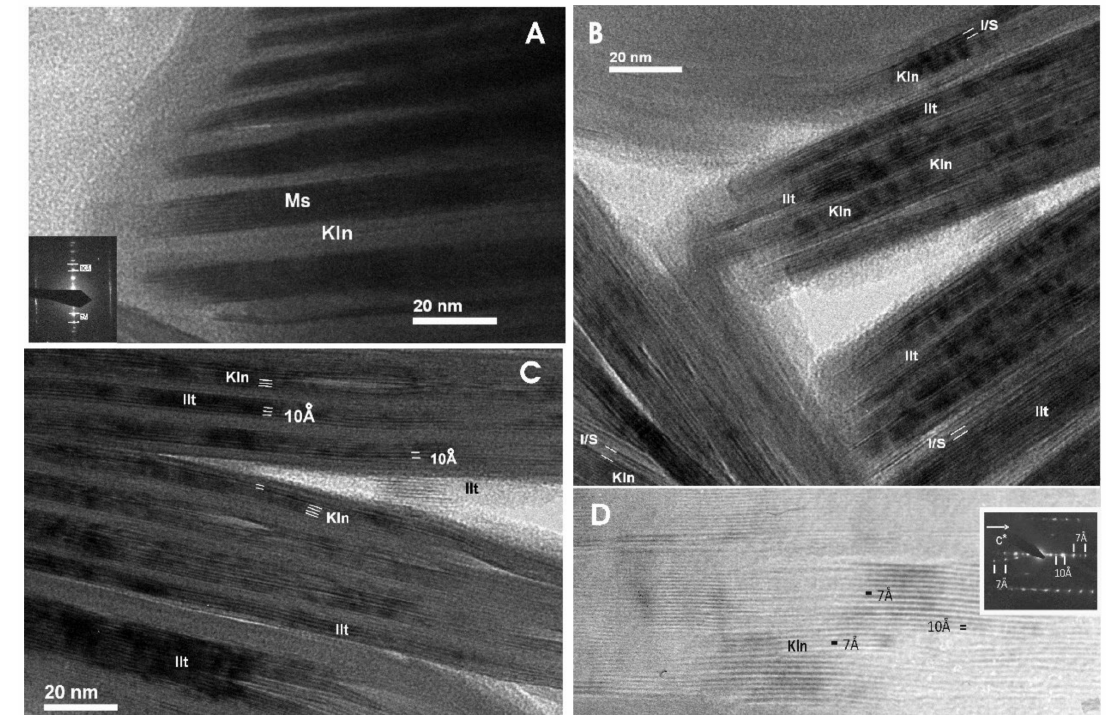
Figure 6. High Resolution TEM images and SAED patterns (insets of mica-kaolinite intergrowths ( A – C ) and 10 Å to 7 Å layer transitions ( D